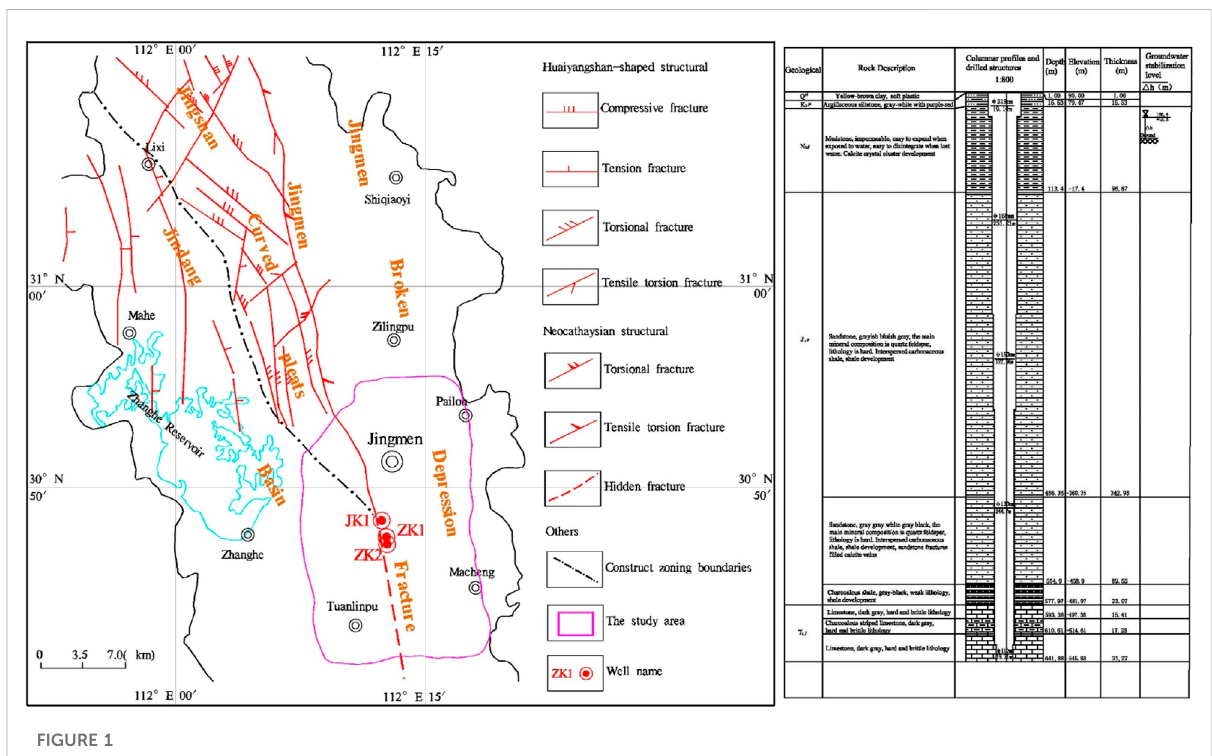
FIGURE 1 Location map of the study